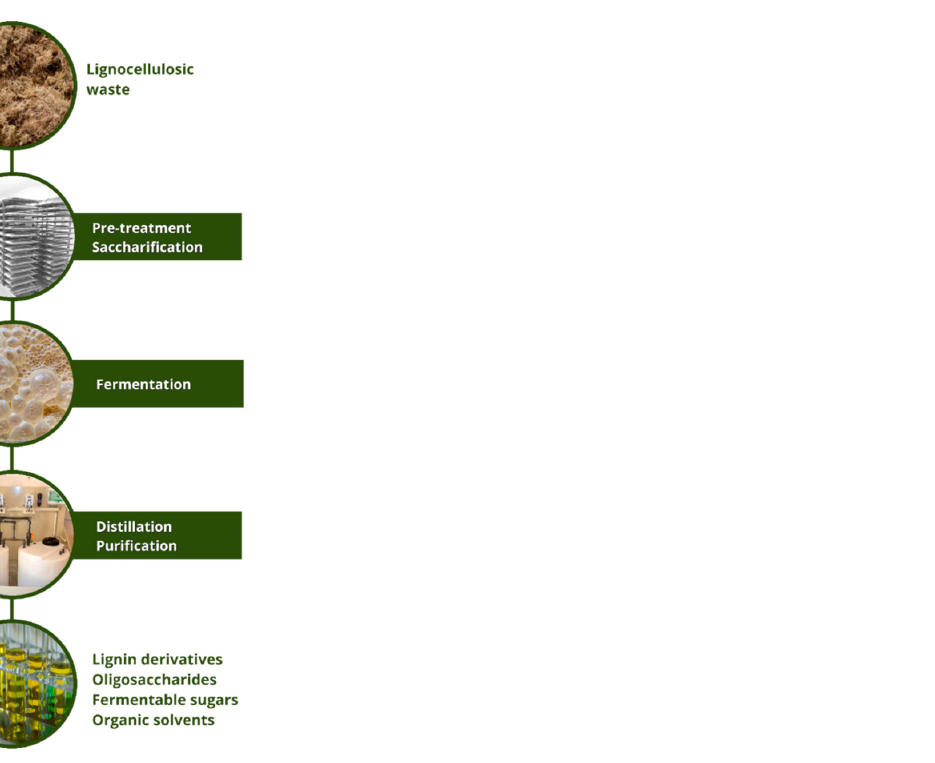
Figure 3. Steps involved in the bioconversion of lignocellulosic waste materials, such as those produced in peach palm exploitation, into useful high-value-added products.